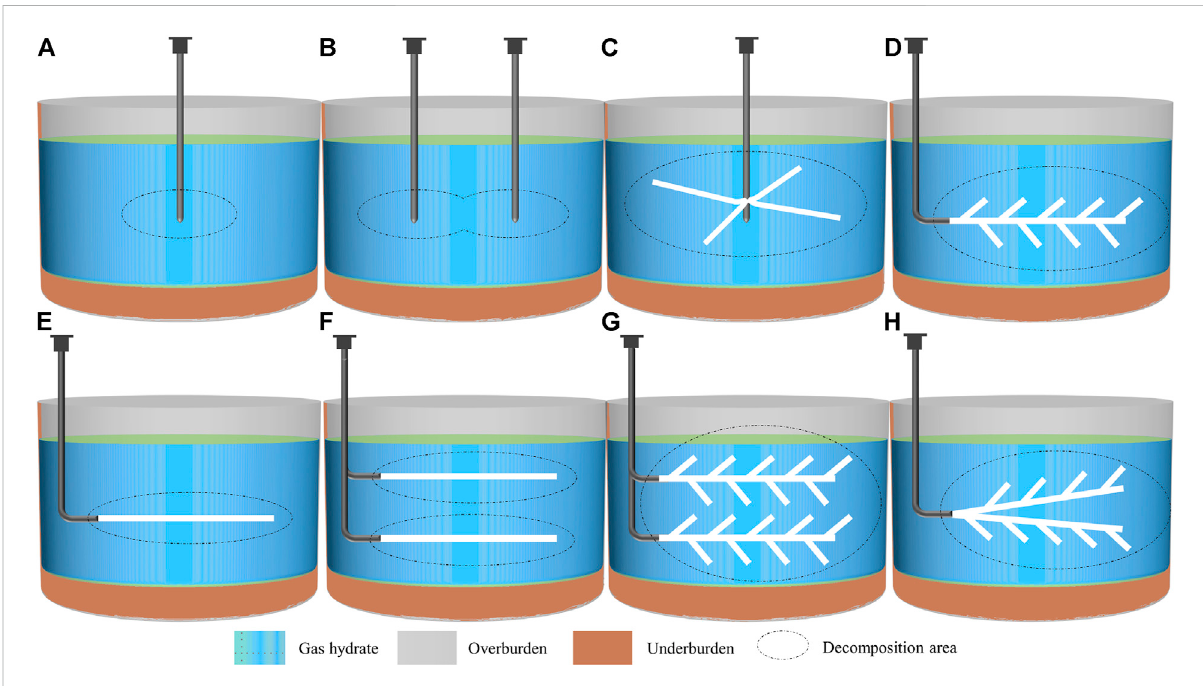
FIGURE 6 Wellborestructuremodelofgashydrateproductionwelltoimprovegasproductionef fi ciency. (A) Singlevertical well, (B) dualverticalwells, (C) radial lateral well, (D) fi shbone well, (E) single horizontal well, (F) dual horizontal wells, (G) dual fi shbone well, and (H) dual branch multilateral horizontal